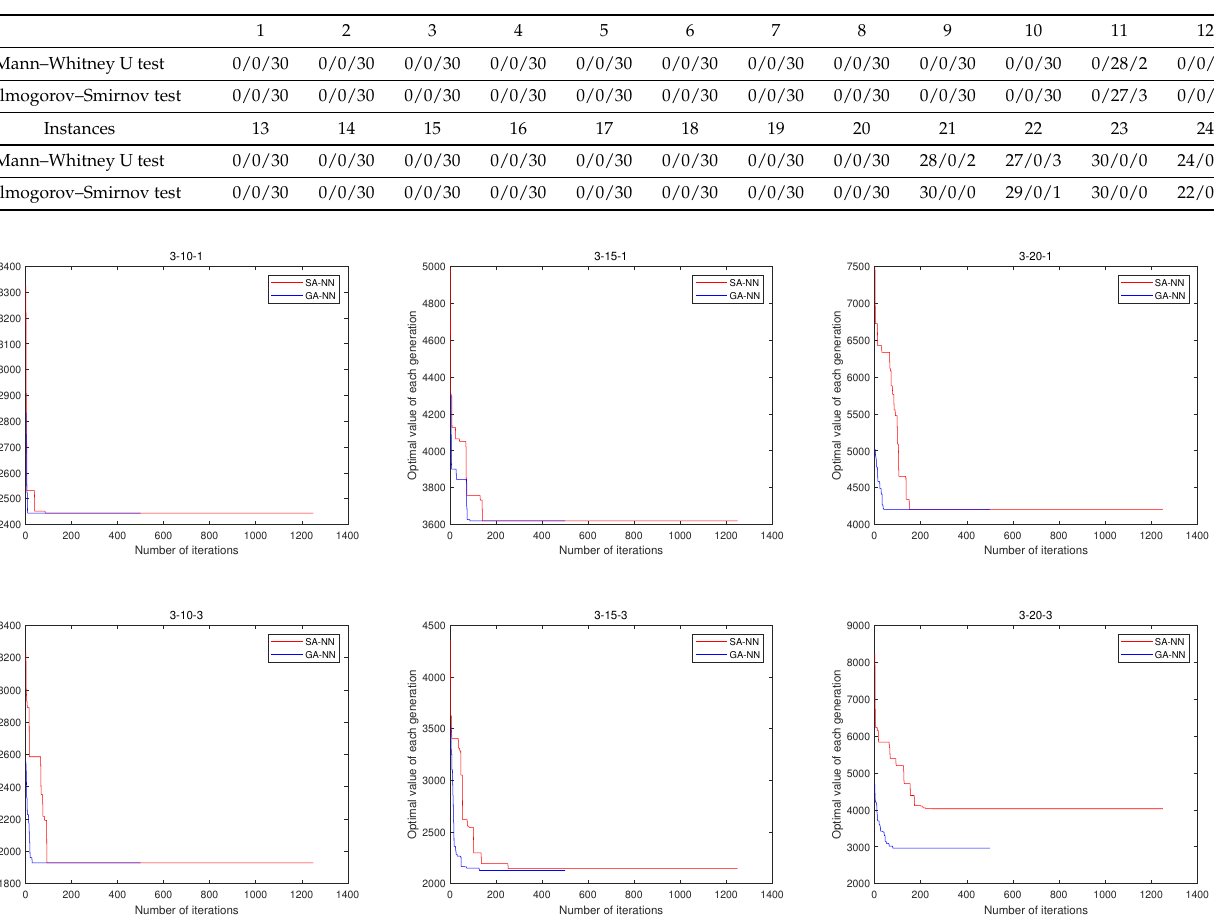
Table 5. Statistical hypothesis test results.